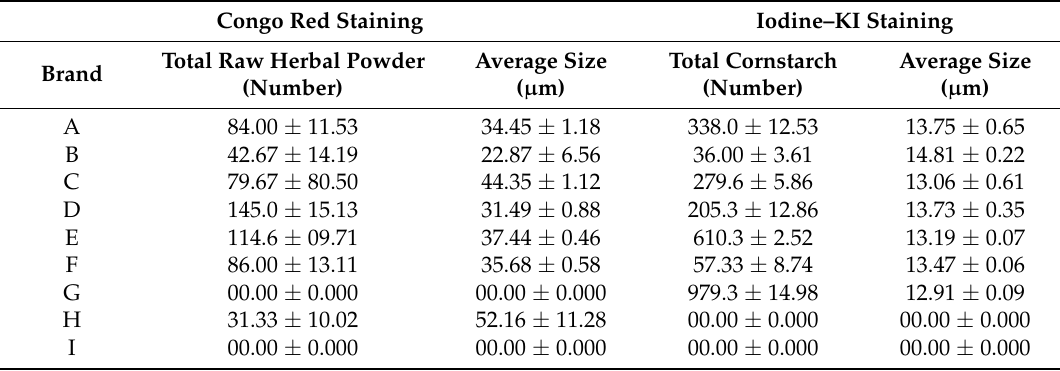
Table 5. Congo red and Iodine–KI staining analysis of total raw herbal powder numbers, total cornstarch numbers, and average size. Congo Red Staining Iodine–KI